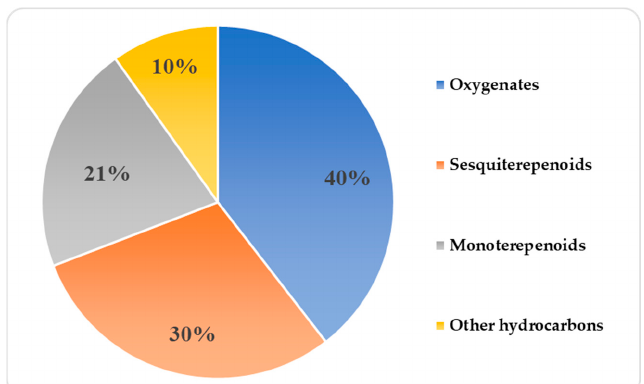
Figure 1. A chart showing the proportions of identified classes of organic compounds of the 81 putatively annotated peaks in the headspace (HS) samples of Zingiber barbatum species. The “oxygenates” pie chart consists of a combination of the alcohols, aldehydes, ketones, and esters classes.